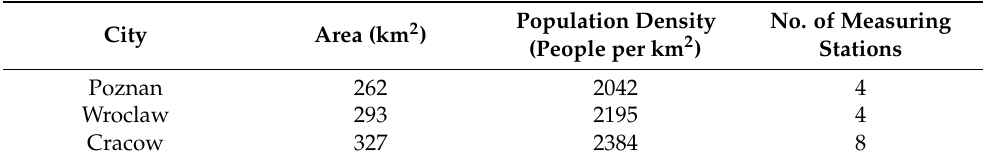
Table 3. Descriptive parameters of analyzed Polish cities